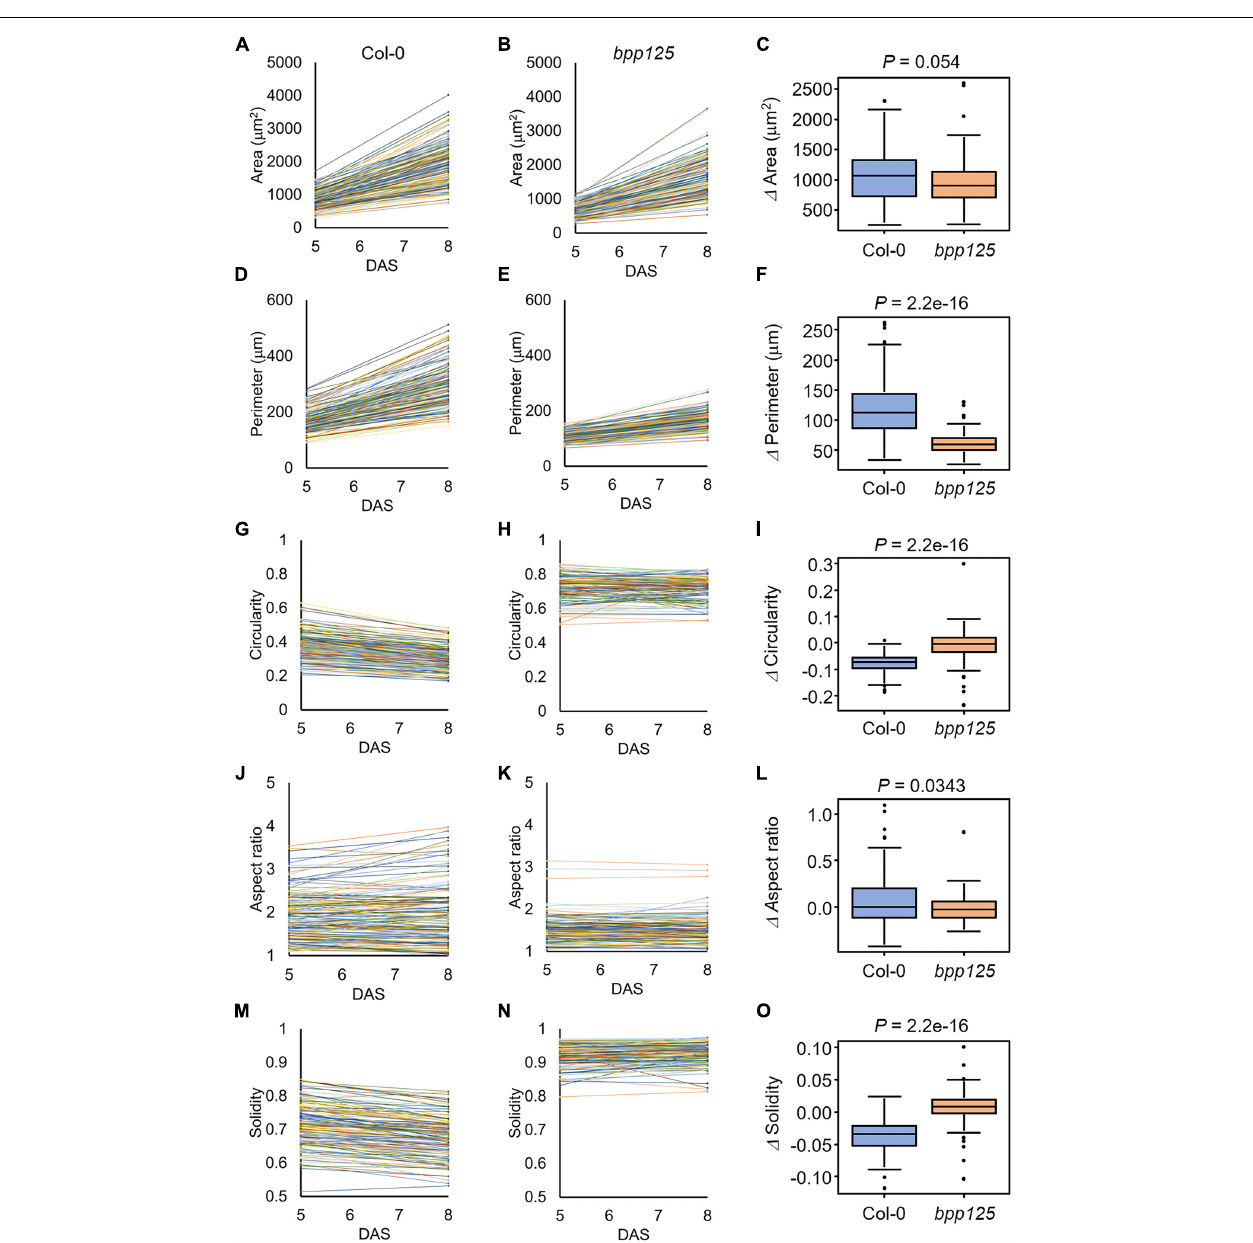
FIGURE 6 | Measurements of morphological features of cotyledon epidermal cells. The results were obtained from 144 [wild type (Col-0)] and 119 ( bpp125 triple mutant) cells from nine independent seedlings at 5 and 8 days after sowing (DAS). (A,B) Time-course of cell area in the wild type (Col-0) (A) and bpp125 (B) . (C) Changes in cell area. (D,E) Time-course of cell periphery length in the wild type (Col-0) (D) and bpp125 (E) . (F) Changes in cell periphery length. (G,H) Time-course of cell circularity in the wild type (Col-0) (G) and bpp125 (H) . (I) Changes in cell circularity. (J,K) Time-course of cell aspect ratio in the wild type (Col-0) (J) and bpp125 (K) . (L) Changes in cell aspect ratio. (M,N) Time-course of cell solidity in the wild type (Col-0) (M) and bpp125 (N). (O) Changes in cell solidity. P -values were determined by Mann-Whitney’s U -test ( N =